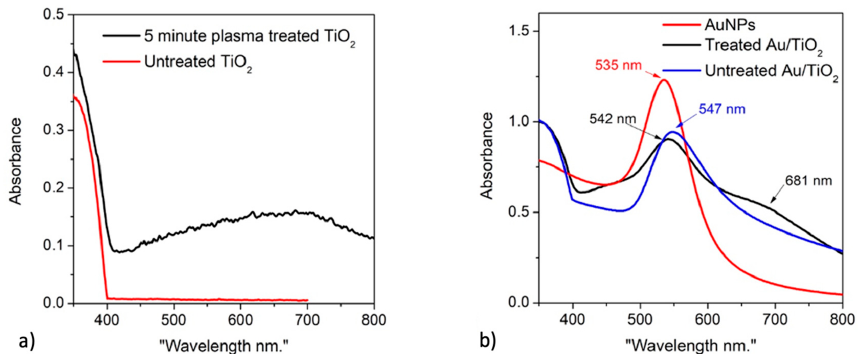
Figure 7. Extinction UV-vis spectra of ( a ) non-treated rutile TiO 2 (red curve), treated rutile TiO 2 with 3% NH 3 , 3% H 2 O 2 under a 5 min plasma treatment (black curve) and ( b ) bare Au-nanoparticles generated from 0.06 mM HAuCl 4 (red curve), non-treated Au / TiO 2 nanocomposite (blue curve), and treated Au / TiO 2 nanocomposite (black curve).